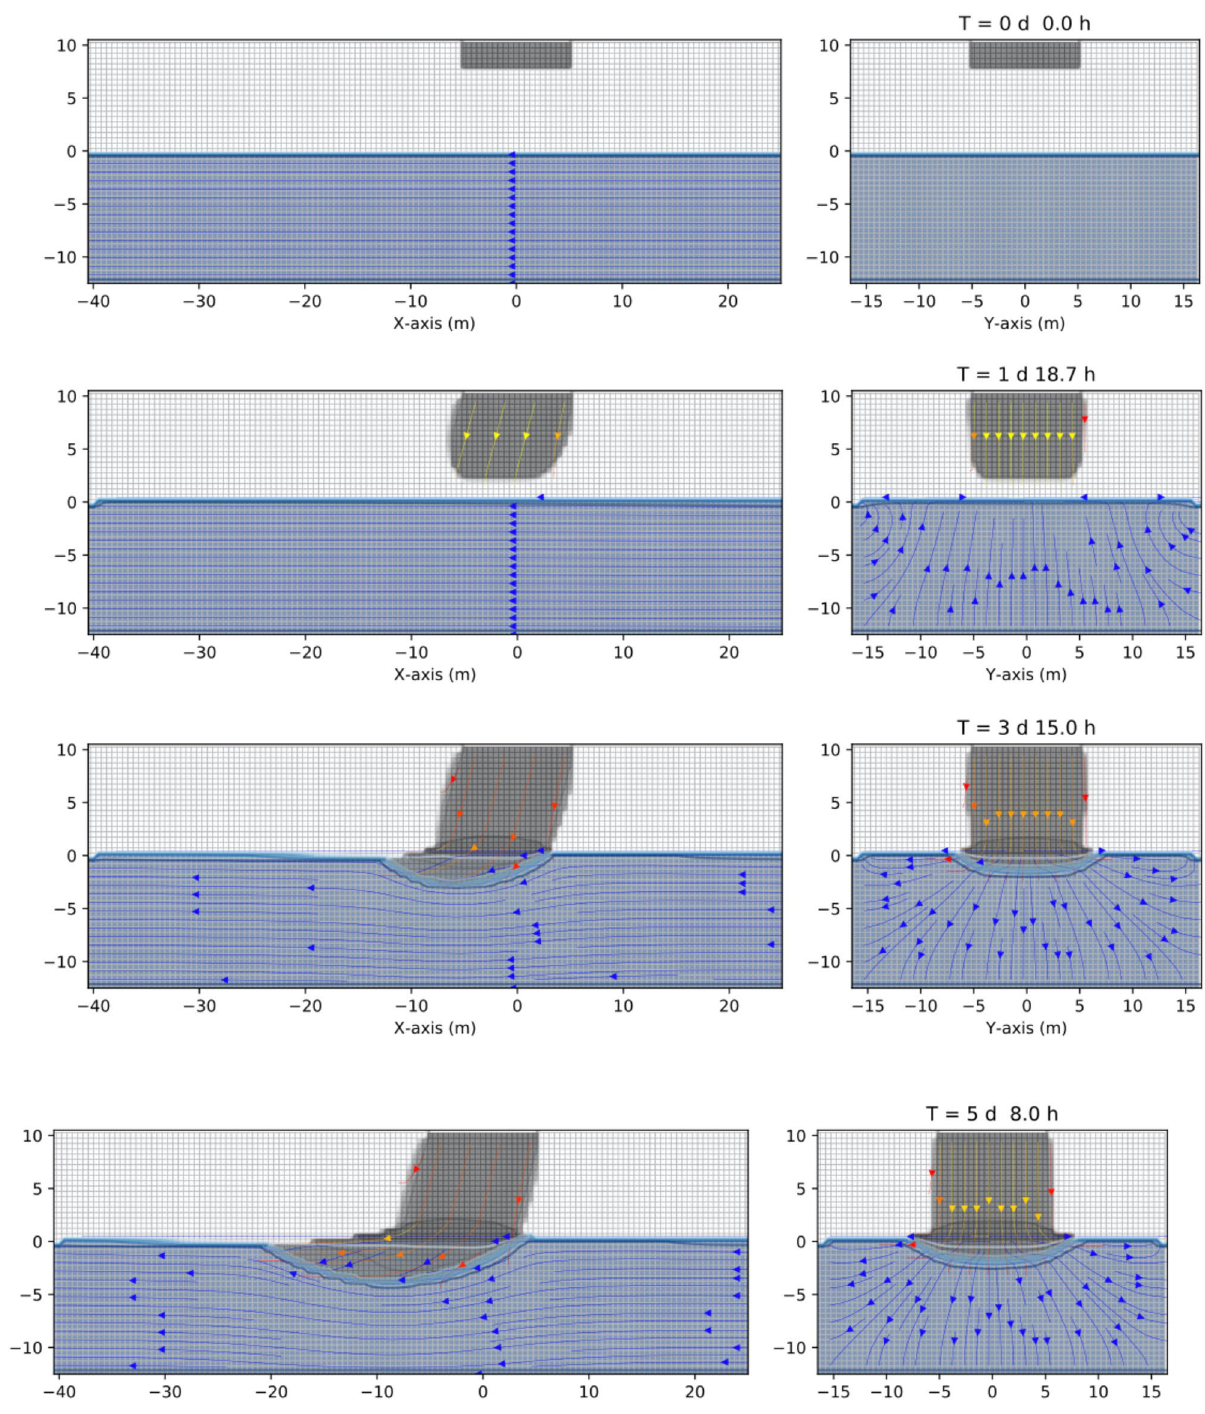
Figure 4. Example of a numerical simulation of a three-phase fluid flow simulation (water + LNAPL + air) performed using a spatial grid resolution of 0.50m and a grid dimension of 80m × 30m × 20m , at different times. The simulation has been performed using CactusHydro code. Left-hand side shows the ( z – x ) plane. Right-hand side shows the ( z – y )